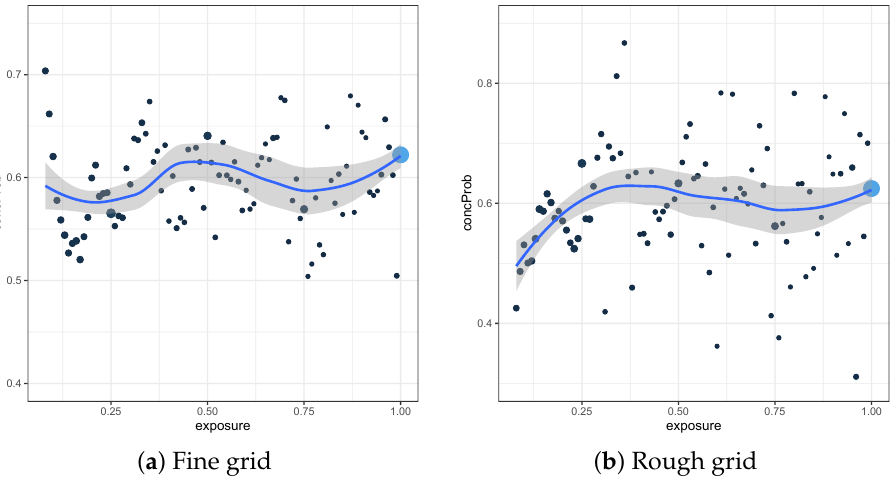
( λ ,0.05 ) in function of the exposure λ , for the 0,1 +